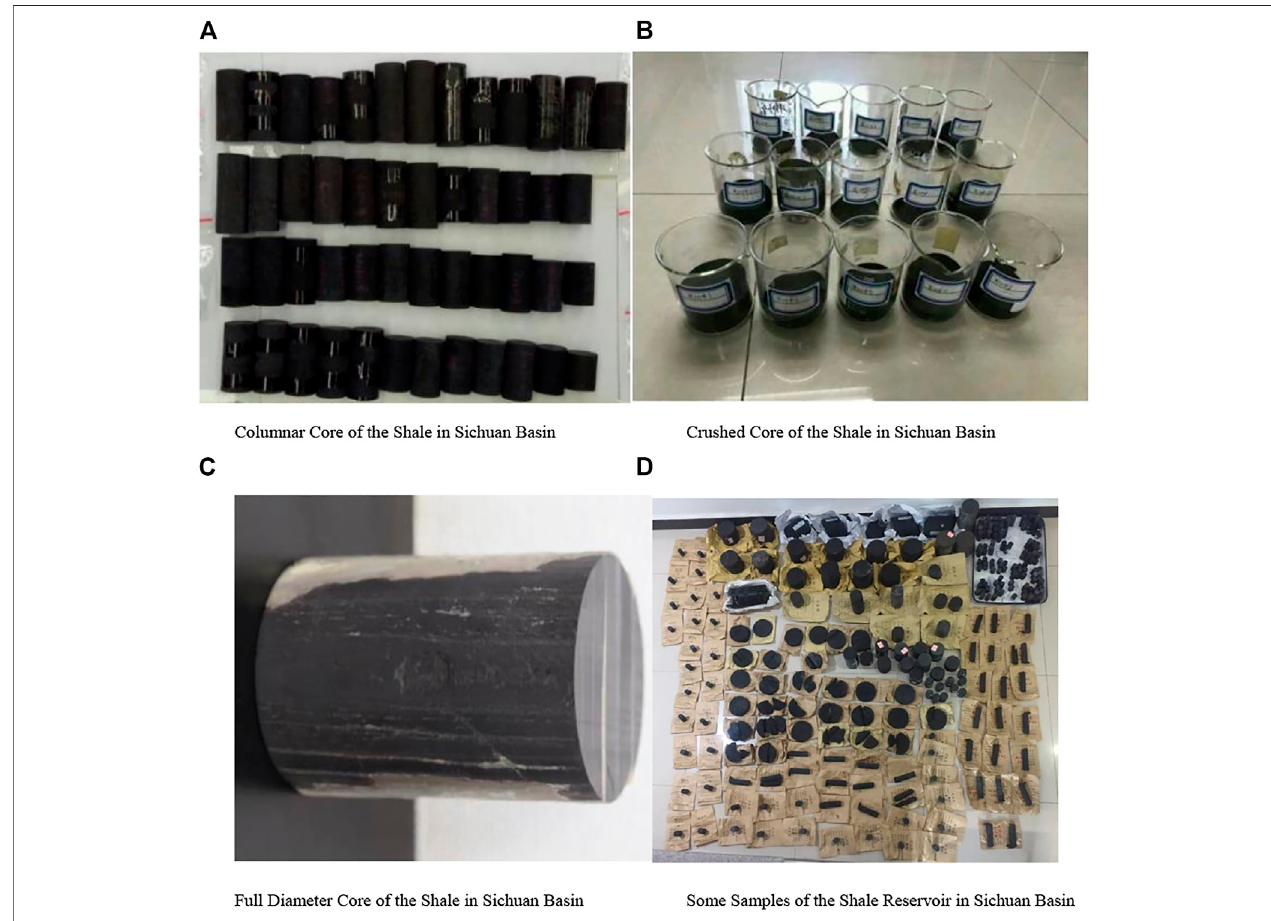
FIGURE 1 | Core samples of the shale reservoir in the Sichuan Basin.